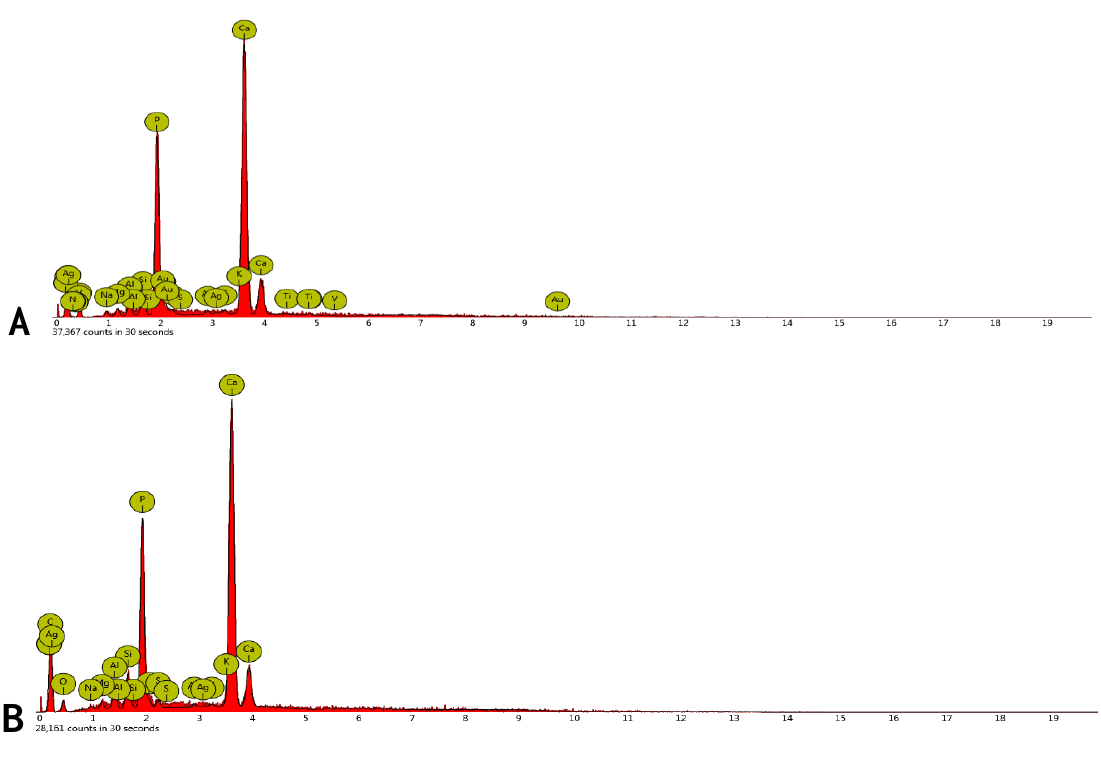
Fig. 3. EDS spectra for bovine (A) and caprine (B) bone